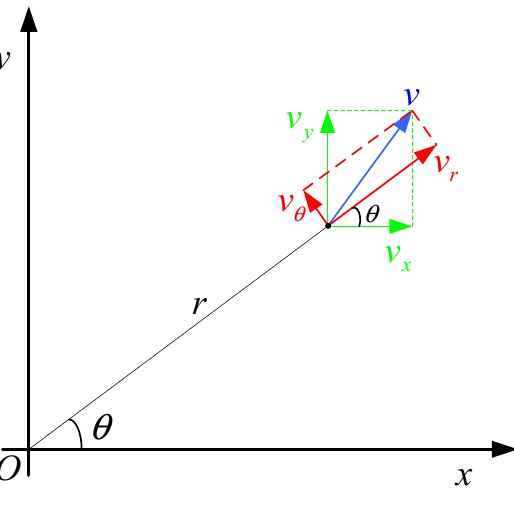
Figure 1. Velocity Figure 1. Velocity decomposition.